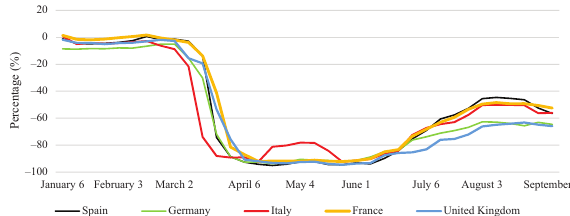
Figure 1. Changes in the total number of global flights year